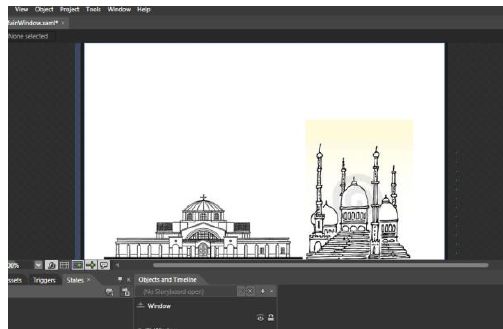
Figure IX. Creating and relocating symbols in a united